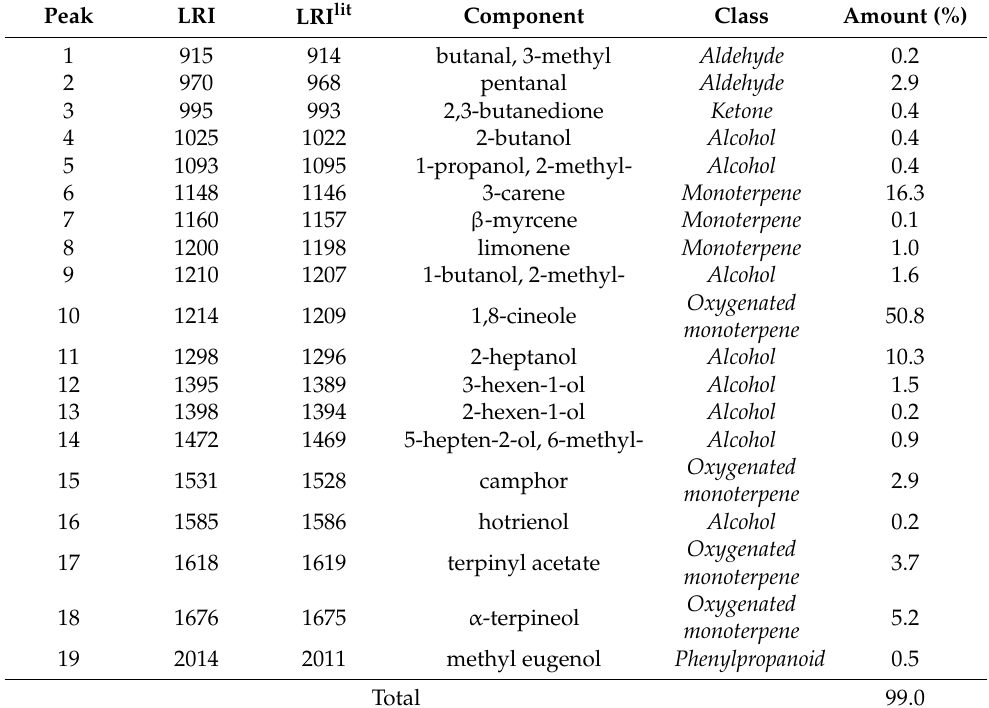
Table 1. Total volatile organic compound (VOC) profiles for the distillate of raspberry leaves by HS-GC/MS. LRI: Linear Retention Indices measured on a polar column; LRI lit : Linear Retention Indices from literature.